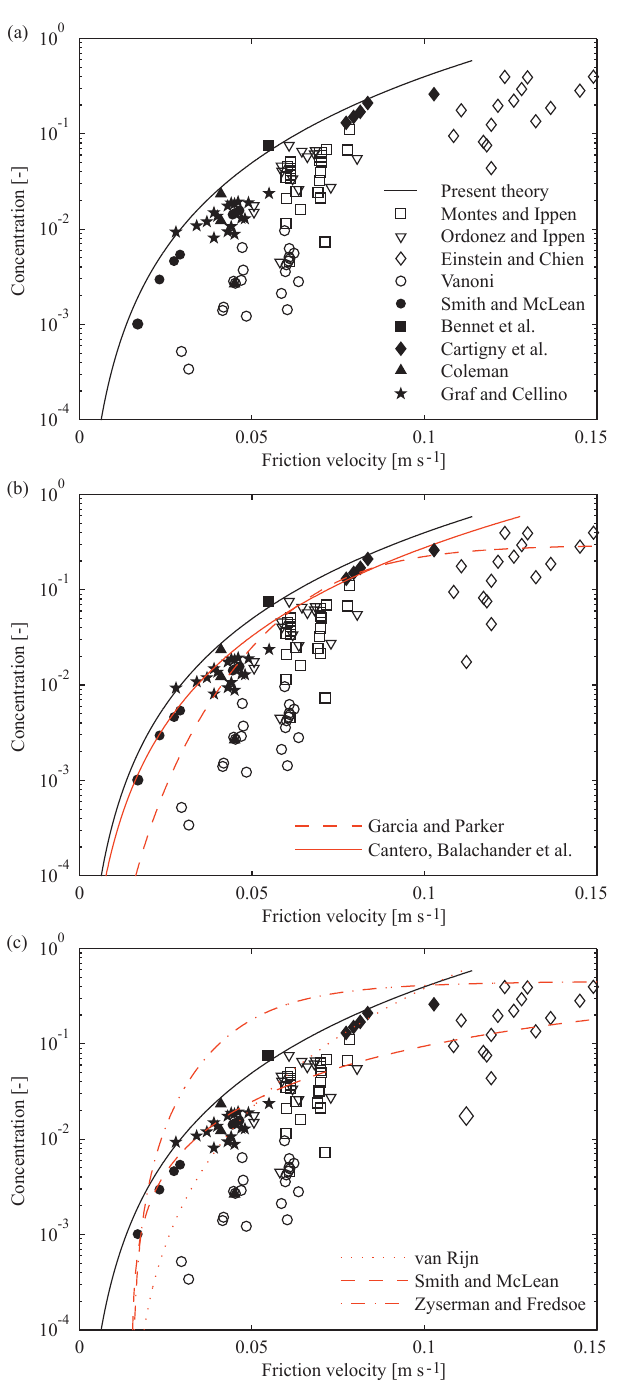
Figure 3. The suspension parameter for saturated suspensions ( (cid:48) = 1) plotted in the space defined by the friction velocity and the near- boundary particle concentration. (a) Comparison of theory to mea- surements of saturated suspensions and measurements of under- saturated suspensions. (b) Comparison of theory to a threshold for turbulence extinction observed in DNS experiments (Cantero et al., 2009, 2011, 2012) and balanced sedimentation–entrainment fluxes (Garcia and Parker, 1993). (c) Comparison of theory to suggested empiric